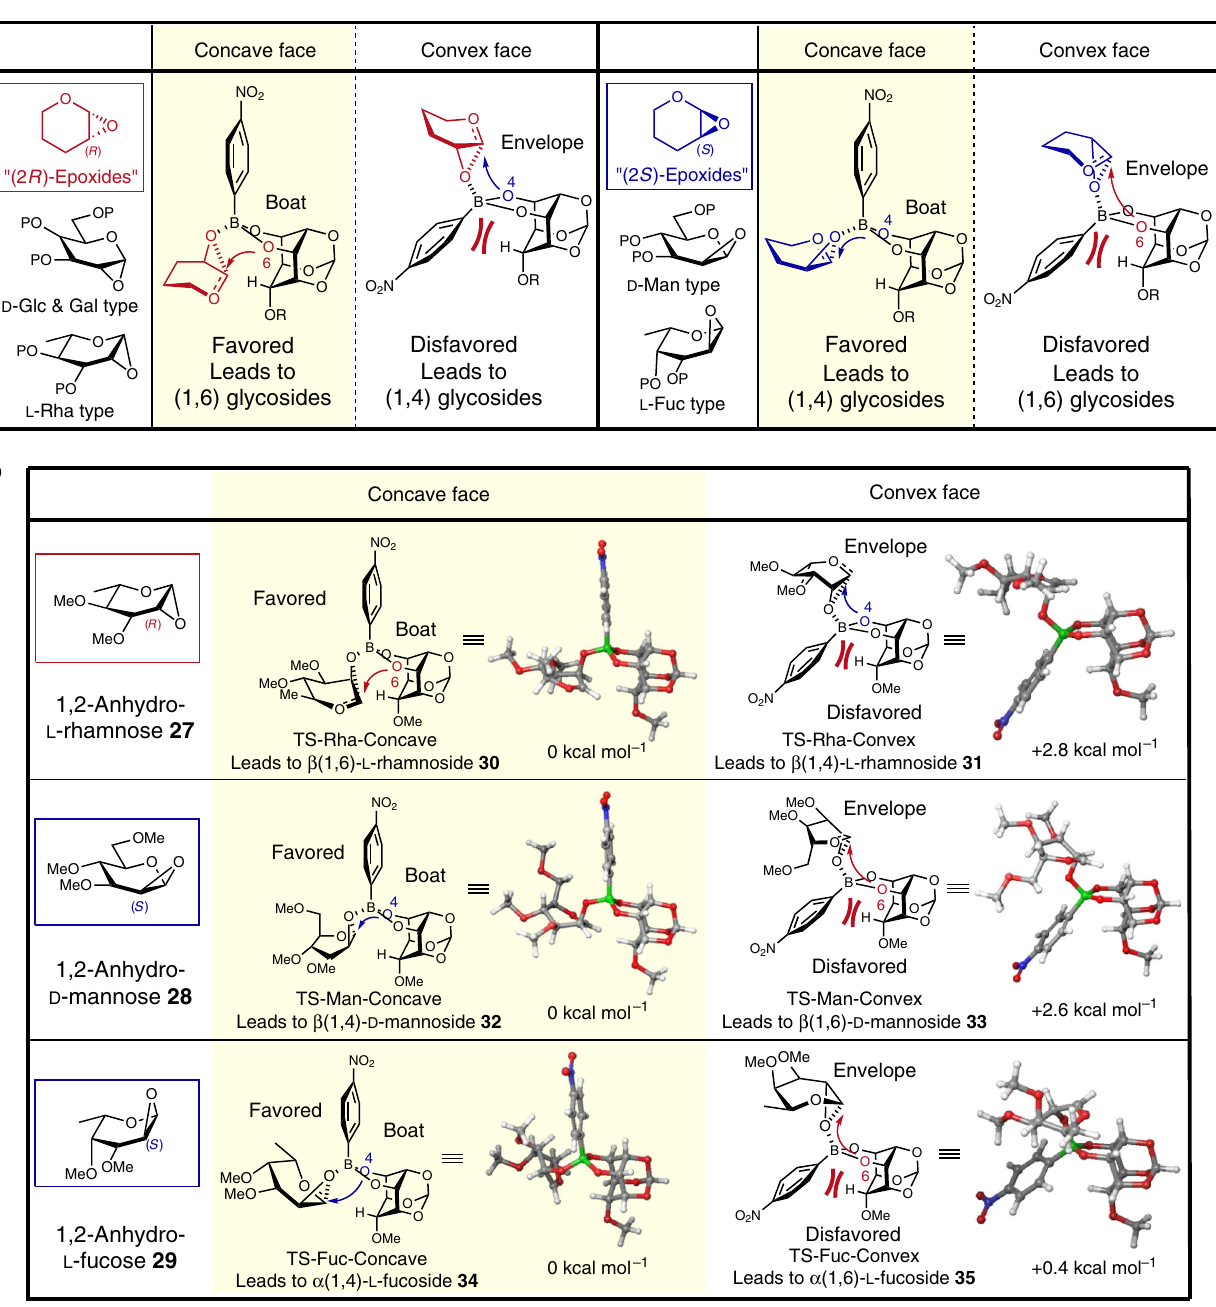
Fig. 4 Desymmetric glycosylation using several 1,2-anhydro donors. a Prediction model for regioselectivity. b Transition states calculated using B3LYP/ 6-31G* (single point energy: B3LYP/6-31 + G**). The atoms colored gray, white, blue, red, and green in transition states represent C, H, N, O, and B,